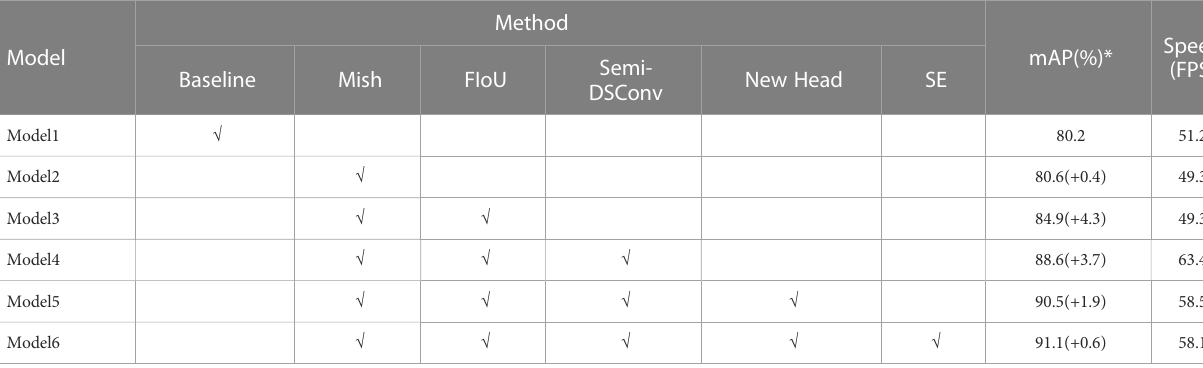
TABLE 2 Results of ablation experiments.